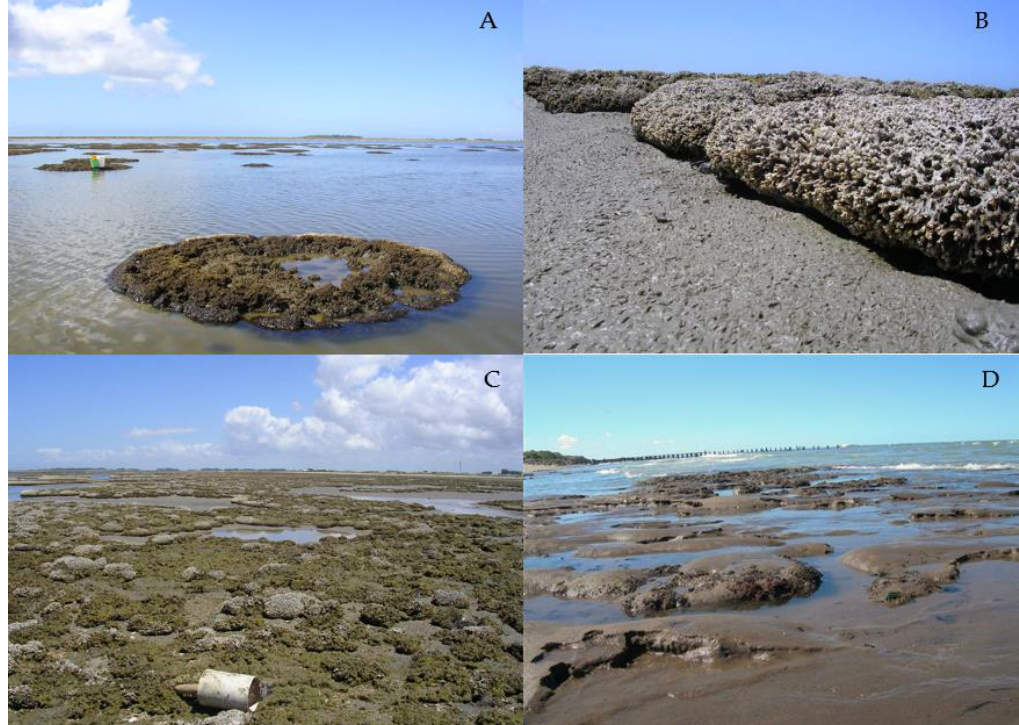
Figure 2. Photographs showing RBP. Reef of Ficopomatus enigmaticus in Mar Chiquita coastal lagoon (Buenos Aires, Argentina) showing different shapes: ( A ) circular and ( C ) platform-type. ( B ) tubes of F. enigmaticus at low tide. ( D ) Reef of Boccardia proboscidea in sewage-impacted area in Mar del Plata coast (Argentina). Photo credit: A, B, C: C.M. Bruschetti; D: M.L. Jaubet.